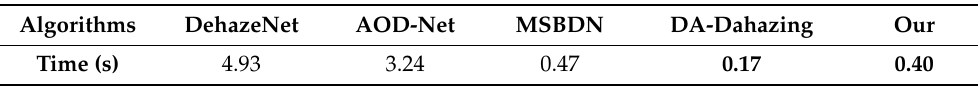
Table 3. Comparison of single image dehazing time for the different dehazing algorithms. Bold texts are the best and our experimental